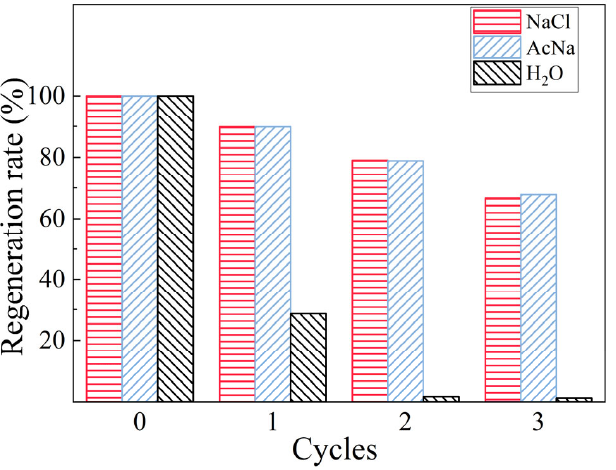
Figure 9. Comparison of three kinds of eluent in three adsorption–desorption cycles of ZMA with Pb(II).